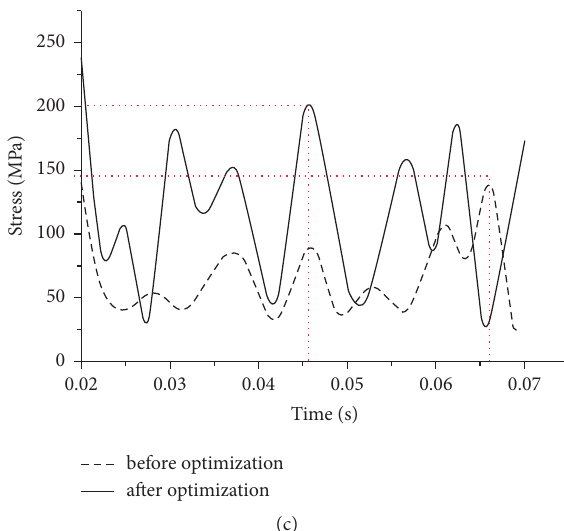
Figure 12: After sudden unloading, the stress cloud diagram and curve of the front and rear columns before and after optimization. (a) Stress cloud diagram of column before optimization. (b) Stress cloud diagram of column after optimization. (c) Stress curve of column before and after optimization.